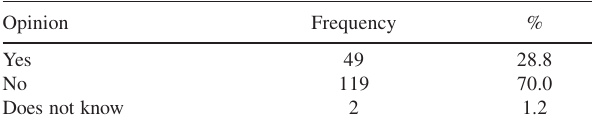
Table 5 - Fear of surgery (n = 170)